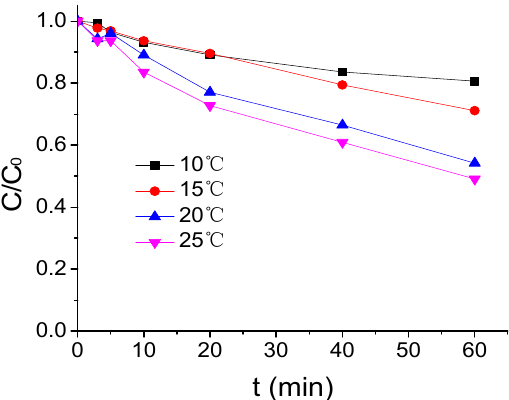
Figure 1. The ATZ removal rate under a different temperature ( C 0 = 1.25 μ mol/L).